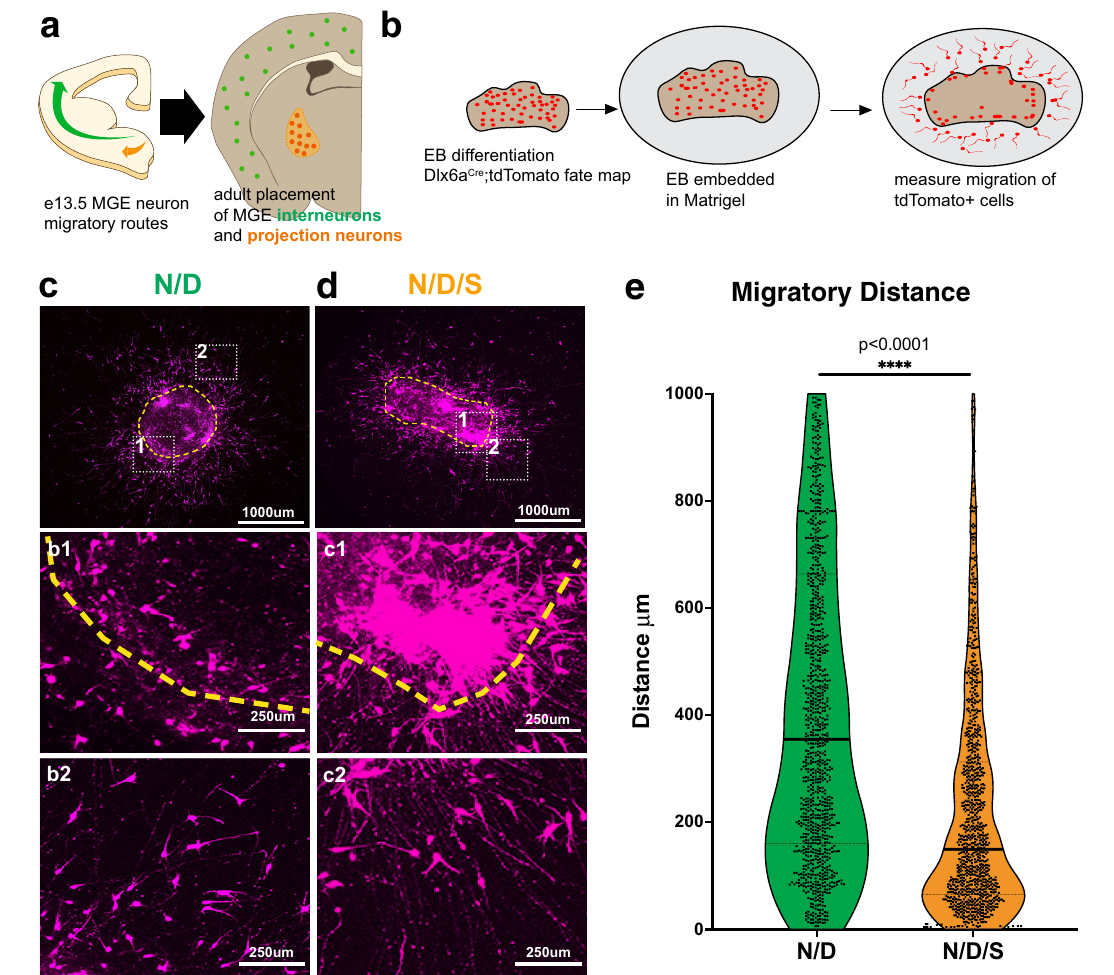
Fig.2|St18GOFinvitroaltersmigratorybehaviorofMGEneurons.a Schematic representation(left) of MGE lineage neurons thatadoptdivergent migratorypaths en route to (right) their fi nal position in the adult brain. Cortical interneurons in green, globus pallidus neurons in orange. b Experimental design for Matrigel embeddingexperiments.N/DandN/D/SlinesaredifferentiatedintoEBsfor12days after which they are embedded in Matrigel. Fate-mapped neurons (Dlx6a Cre ; Ai9) are allowed to migrate radially into Matrigel for 4 days before quanti fi cation. c Representative image of N/D EB with Ai9 tdtTomato in magenta. Yellow dashed